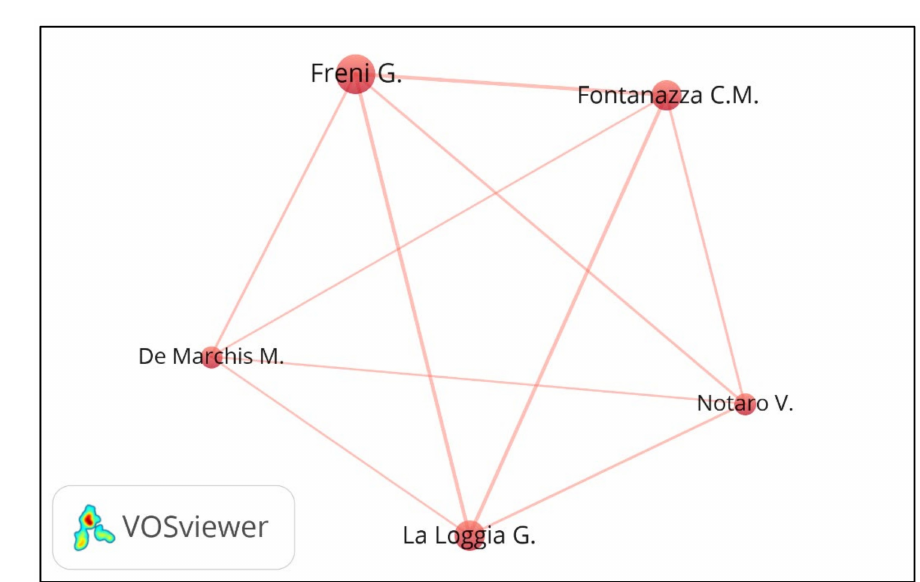
Figure 9. The network visualization map of co-authorship links between scholars. Five